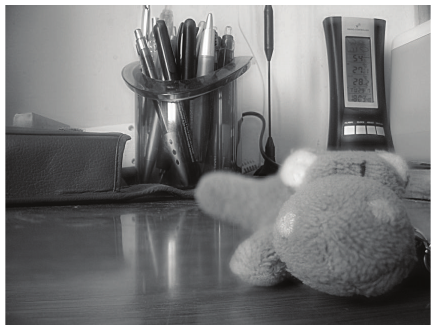
Figure 2: The SA fusion of the image “Table,” approximate run time: 1,6